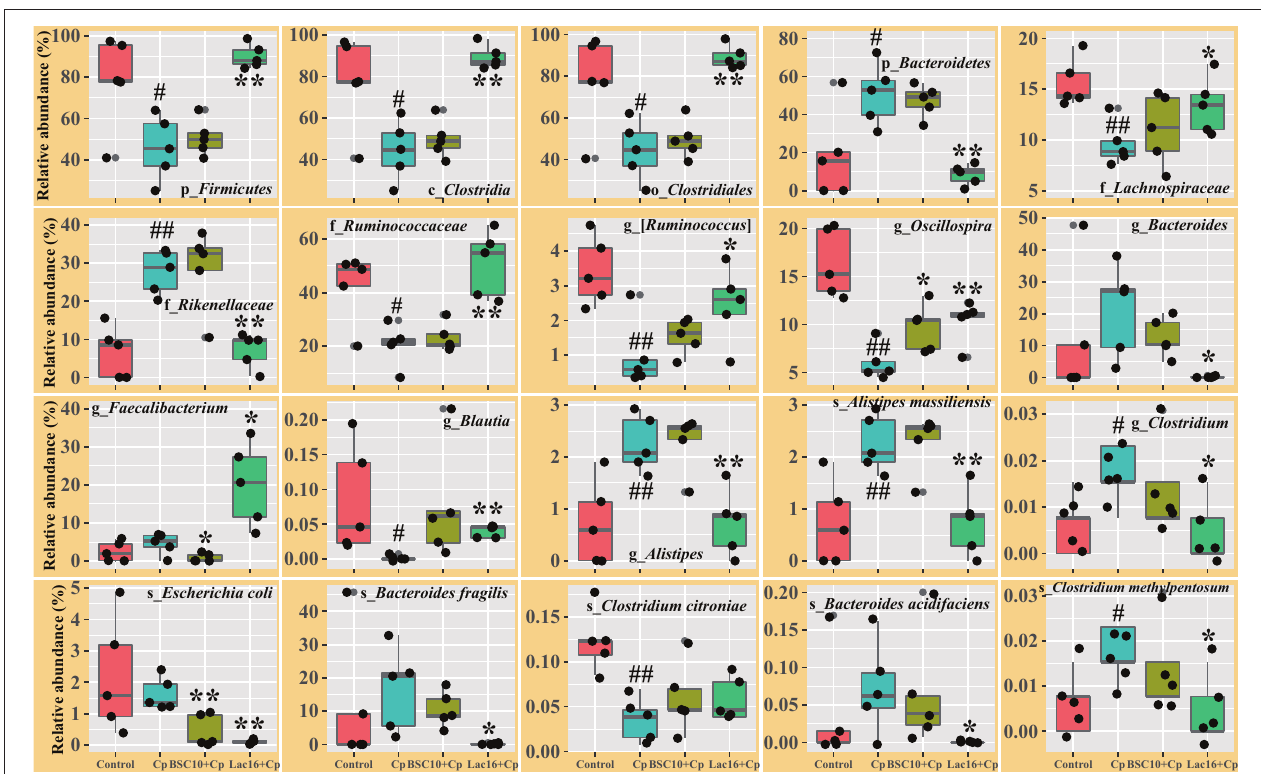
FIGURE 5 | Comparison of the intestinal microbiota among the groups. Significant differences vs. the control group: # p < 0.05; ## p < 0.01. Significant differences vs. the Cp group: * p < 0.05; ** p < 0.01. The prefixes “p_,” “c_,” “o_,” “f_,” “g_,” and “s_” represent the annotated level of phylum, class, order, family, genus, and species. n = five